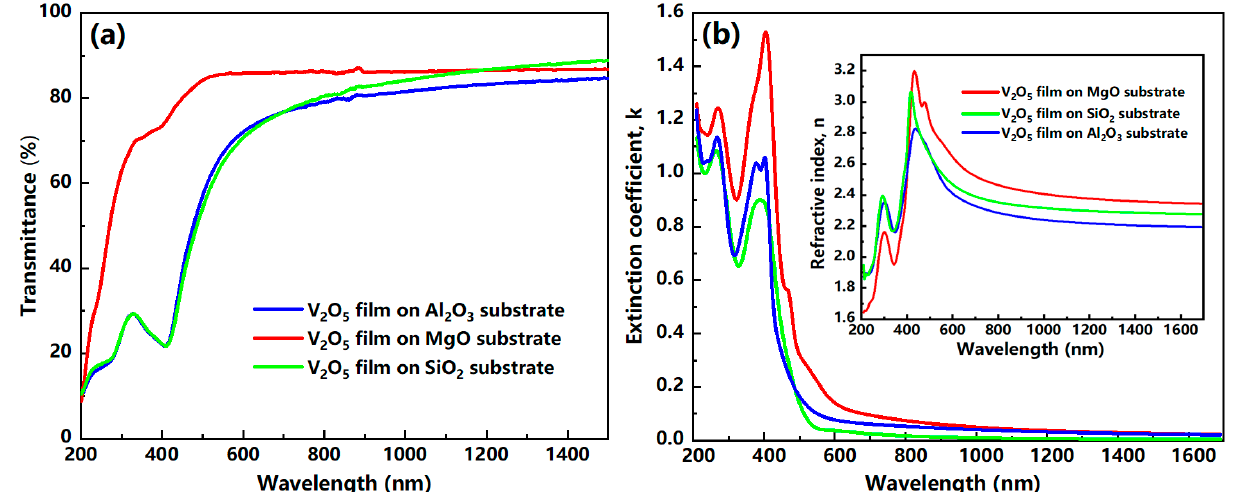
Figure 3. ( a ) Transmittance, ( b ) refractive index, and extinction coefficient for the 50 nm thick V 2 O 5 films on three substrates (Al 2 O 3 /MgO/SiO 2 ).